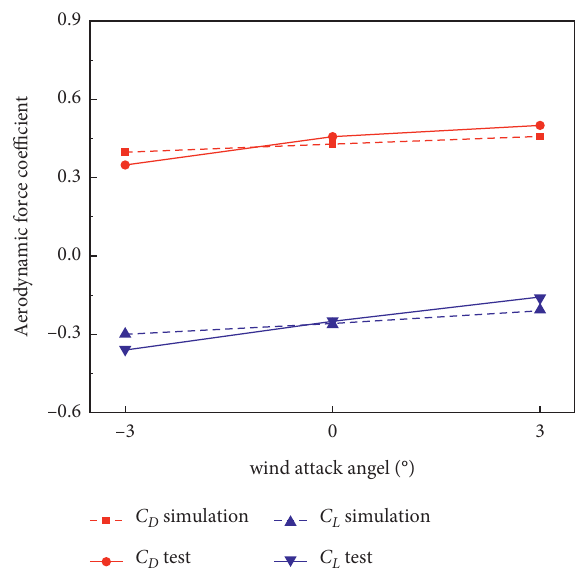
Figure 6: Verification of grid reliability.